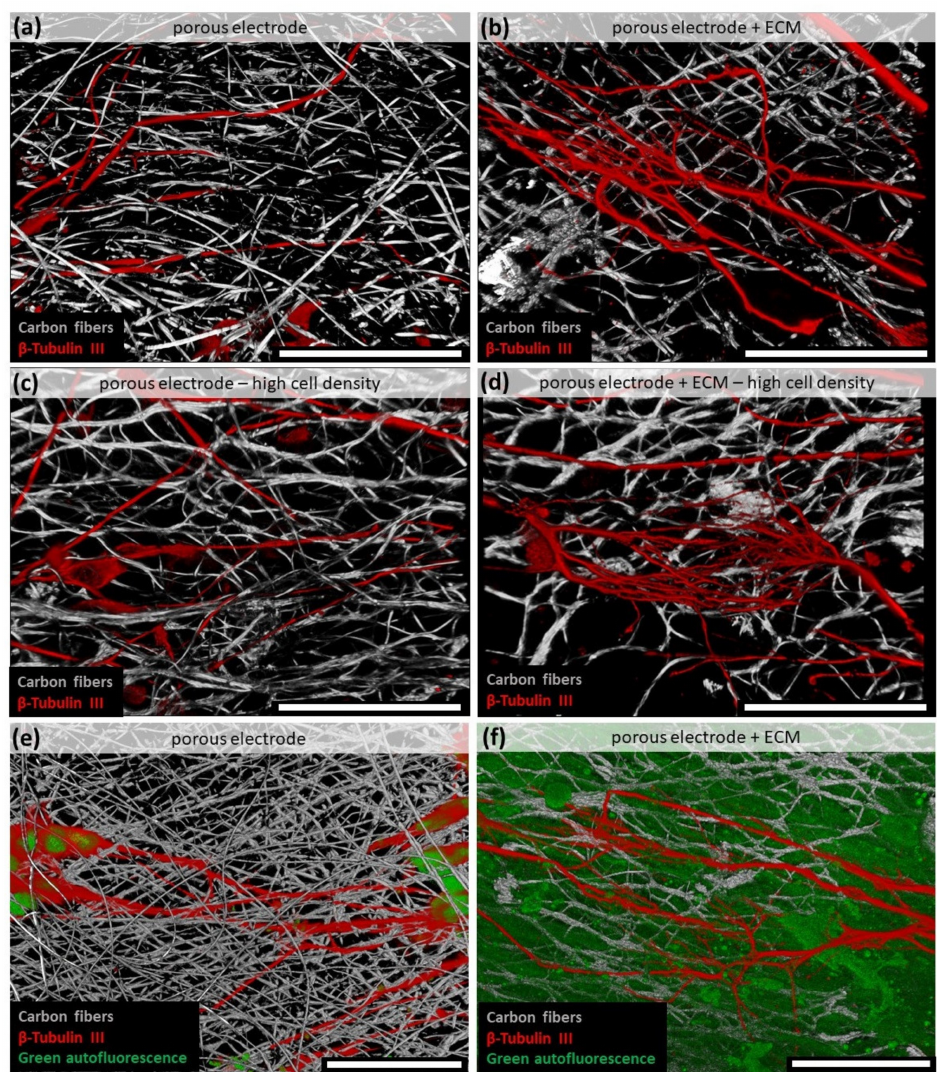
Figure 5. 3D imaging of axons on the porous carbon nanofiber scaffolds. ( a ) The unmodified porous scaffold acts as 3D scaffold for the axons. ( b ) After ECM modification, the axons were more located on the electrode surface but severely increased in branching. ( c , d ) By raising the seeded cell number, the number of axons in/on the electrode increased. When addressing the autofluorescence of the biological tissue in the GFP related excitation/emission area, just the cell bodies on the bare carbon fiber electrode showed a green emission ( e ). The ECM modified porous electrode displayed a green fluorescence overall the electrode surface ( f ). Scale bars correlate to 50 µ m in all